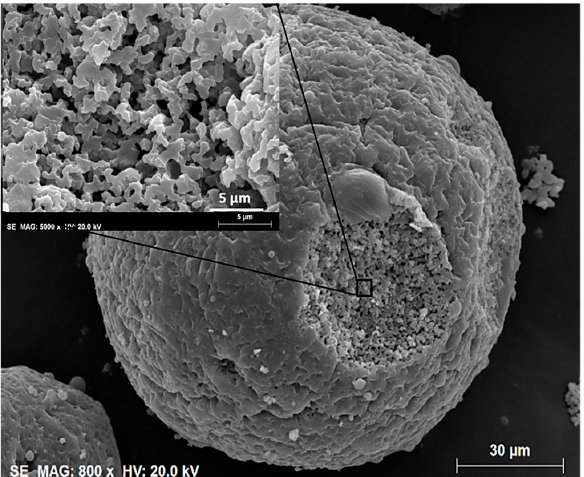
Figure 27. Macro/mesoporous epoxy-functionalized silica microspheres (MICROSCAFS), synthe- sized from TEOS and GPTMS, obtained by emulsion combined with sol-gel transition and phase separation, in the absence of any gelation or phase separation inducer additive. Reprinted from Mi- croporous Mesoporous Mater., Vol. 261, M.V. Loureiro, M. Vale, A. De Schrijver, J.C. Bordado, E. Silva,